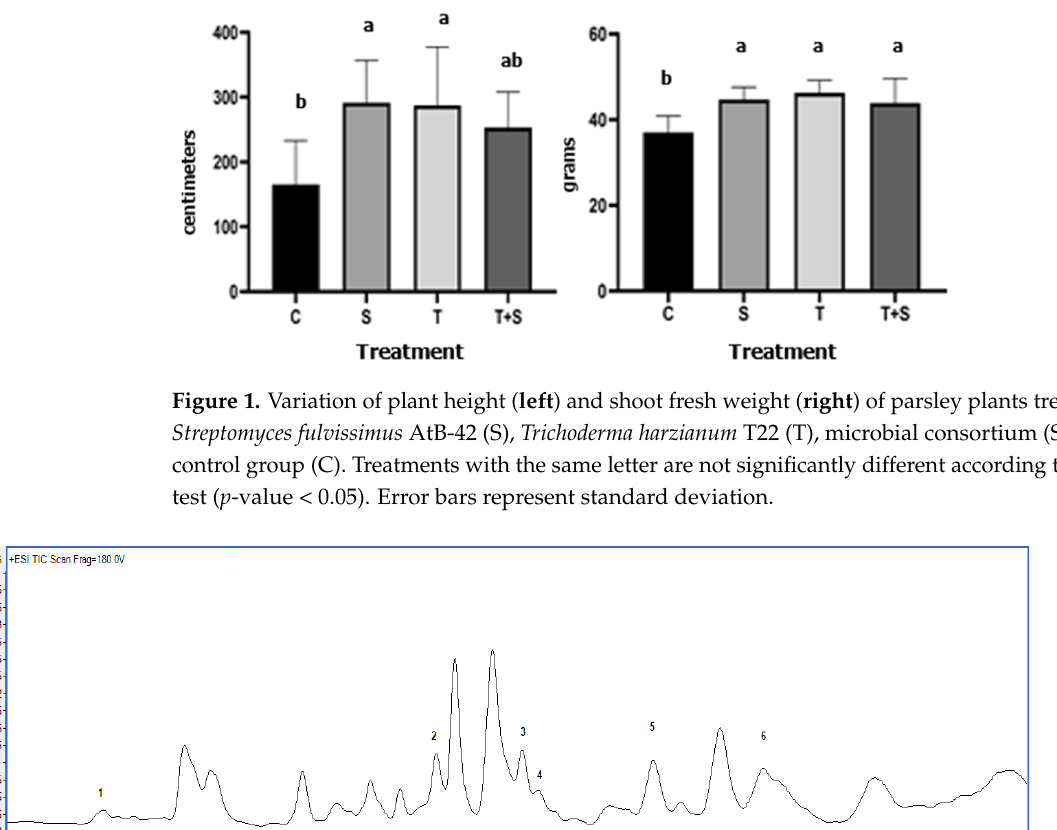
Figure 1. Variation of plant height ( left ) and shoot fresh weight ( right ) of parsley plants treated with Streptomyces fulvissimus AtB-42 (S), Trichoderma harzianum T22 (T), microbial consortium (S + T) and control group (C). Treatments with the same letter are not significantly different according to Tukey’s test ( p -value < 0.05). Error bars represent standard deviation.